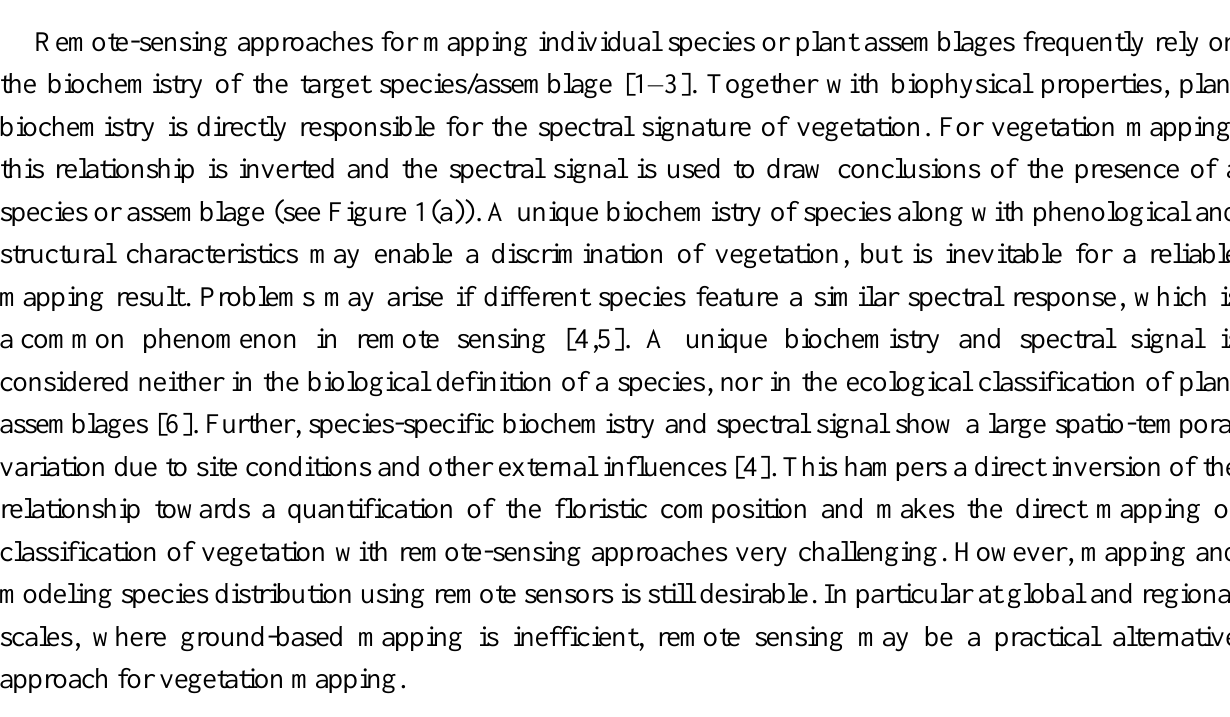
Figure 1. Direct ( a ) vs. indirect ( b ) relationships between floristic composition and spectral responses of vegetation